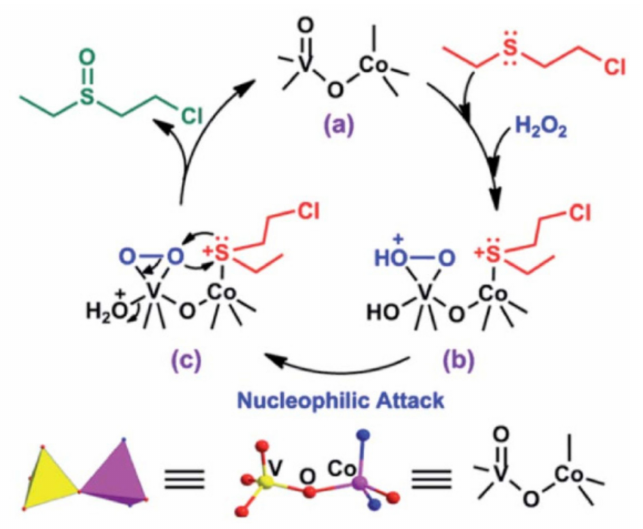
Figure 13. Proposed catalytic mechanism of V–Co–MOF catalyses CEES oxidation. Reproduced with permission from